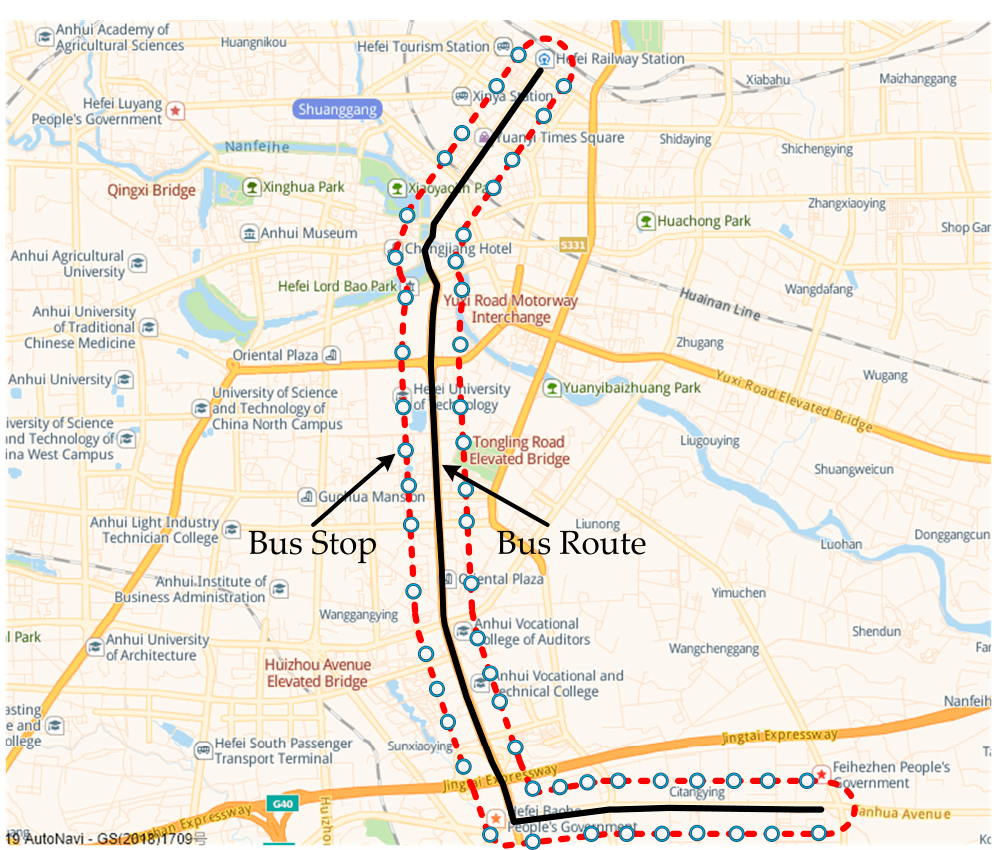
Figure 6. The bus route in Hefei, Anhui, China used in the simulation.